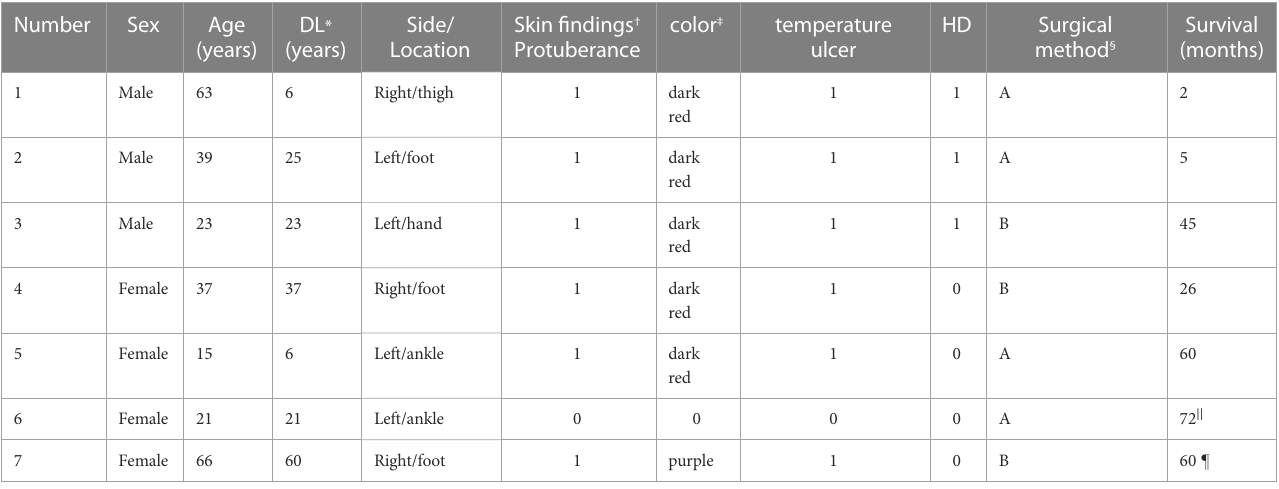
*Calculation methodindurationoflymphedema: startingpoint istheyearofdiagnosisoflimblymphedema, endpoint isthe yearofdiagnosisofSTS,takingthe wholeyearasthecountingunit. † ,0, negative;1,positive. ‡ ,thecolorofspotintheskin.§,Arepresentswideresection;Brepresentsamputation.||,alivewithlungmetastasis. ¶ ,alivewithlungmetastasisandbonemetastasis.HDrefersto hematological